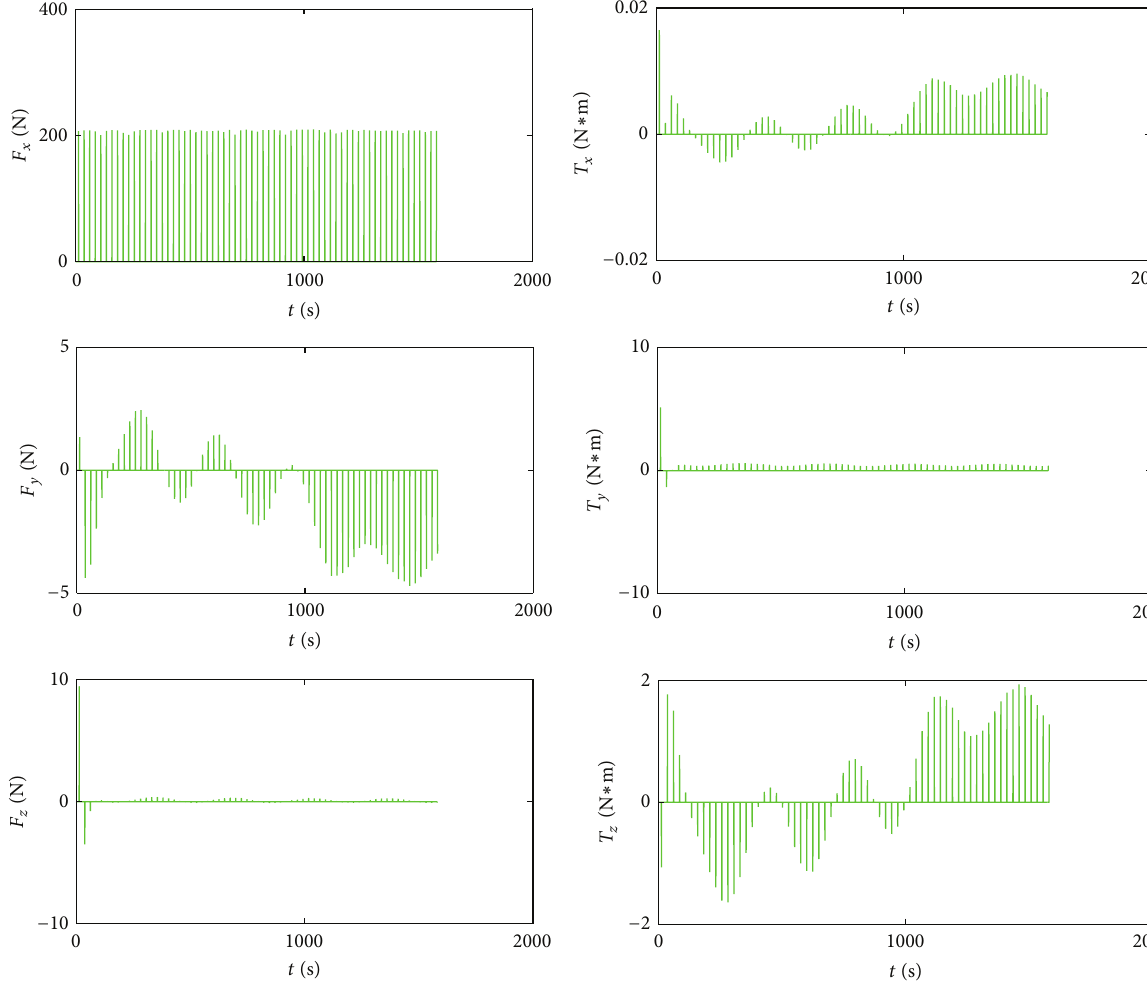
Figure 15: The components of the tension force ( 𝐹 𝑥 , 𝐹 𝑦 , and 𝐹 𝑧 ) and the disturbing torque ( 𝑇 𝑥 , 𝑇 𝑦 , and 𝑇 𝑧 ) in 𝜋 𝐴 caused by the